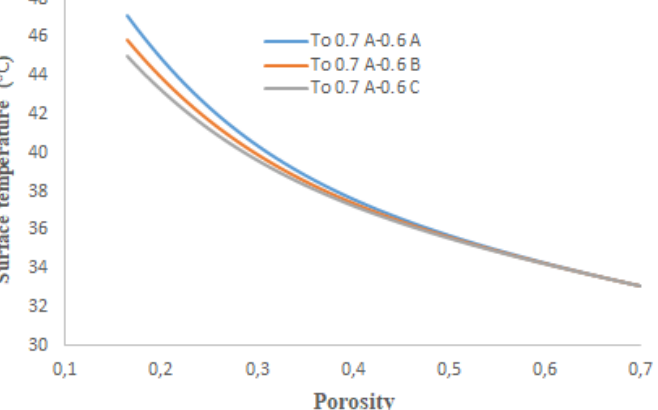
Figure 6. The effect of material porosity on the temperature at the top surface of the